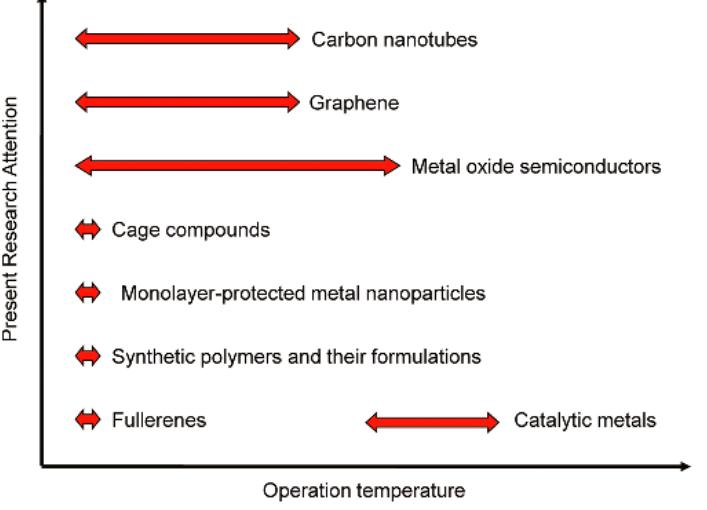
Figure 12. The temperature of sensor operation in relative scale. Reproduced with permission from Reference [48].